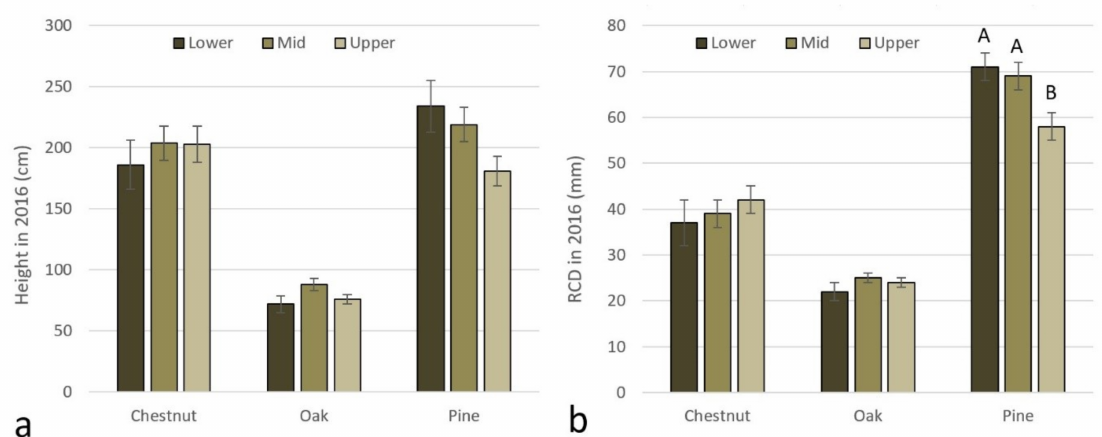
Figure 8. Mean 2016 ( a ) height and ( b ) root collar diameter of seedlings at lower, mid, and upper slope positions. Di ff erent letters indicate significant di ff erences between slope positions within a species. An absence of letters indicates that no significant di ff erence was